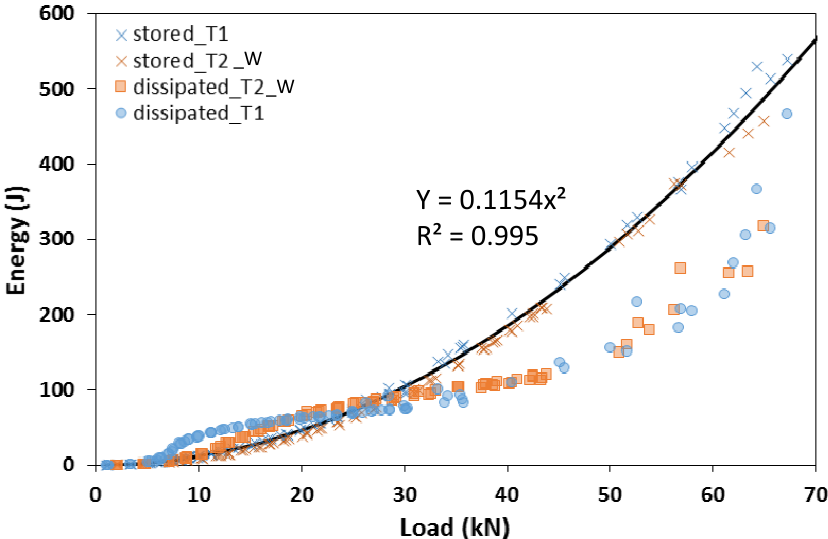
Figure 10. Stored and dissipated energy as a function of the maximum load for each cycle concerning T1 and T2_W specimens.